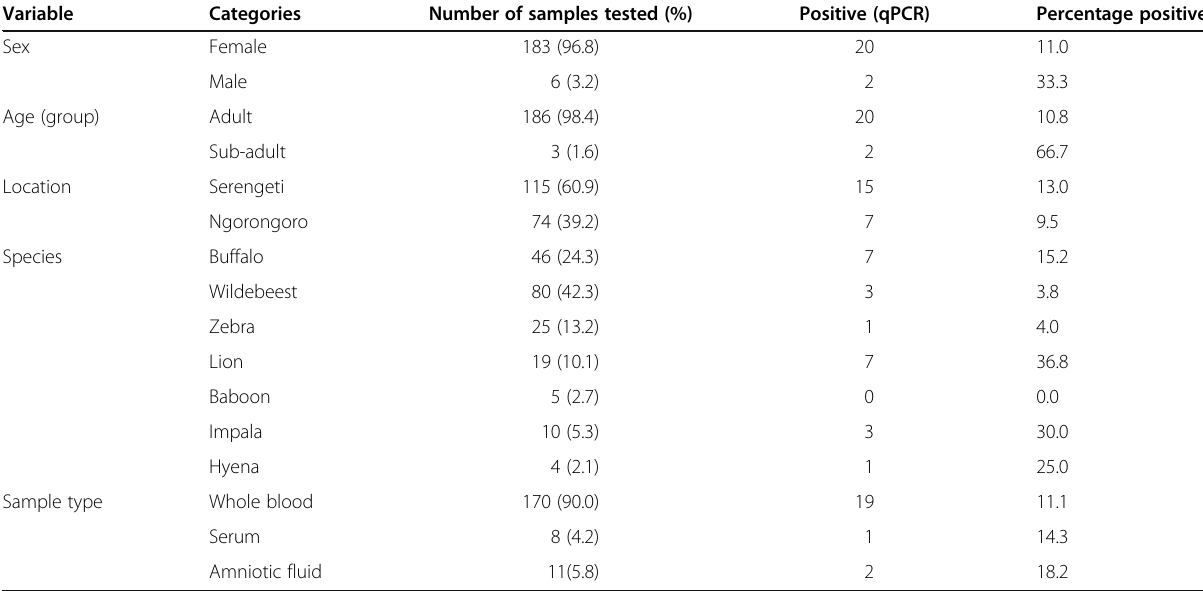
Table 1 Characteristic features of whole blood, serum and amniotic fluid samples from wild animals of the Serengeti